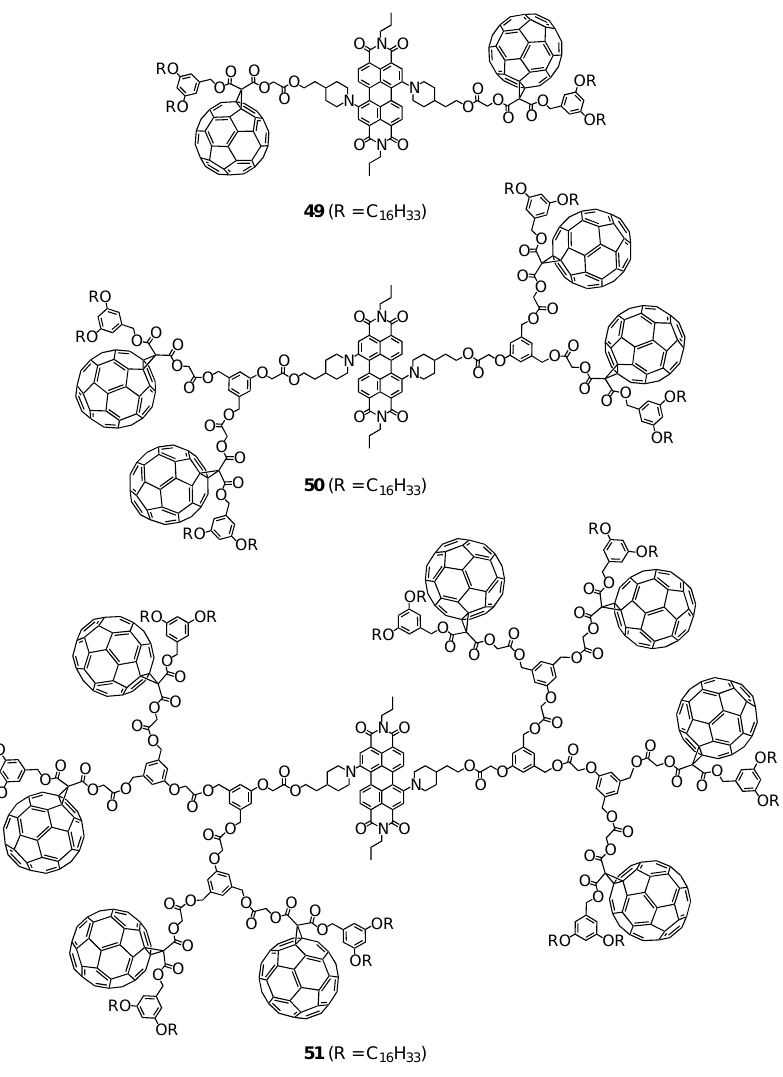
Figure 6. Perylenediimide-centred first to third generation fullerodendrimers 49 - 51